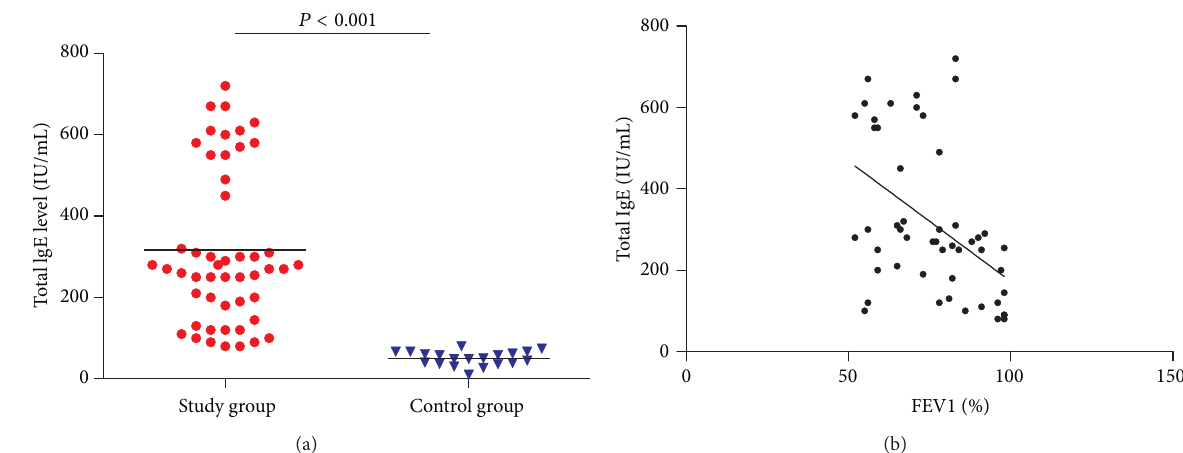
Figure 1: (a) Total IgE level in study and control group. (b) Correlation between total IgE and % FEV1 levels in study group.